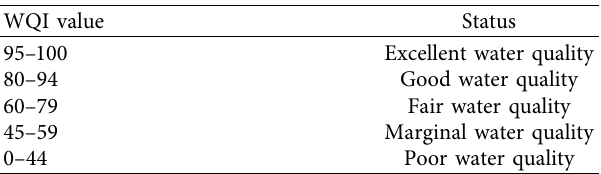
Table 1: Classification of water quality based on the WQI method as described by [22].